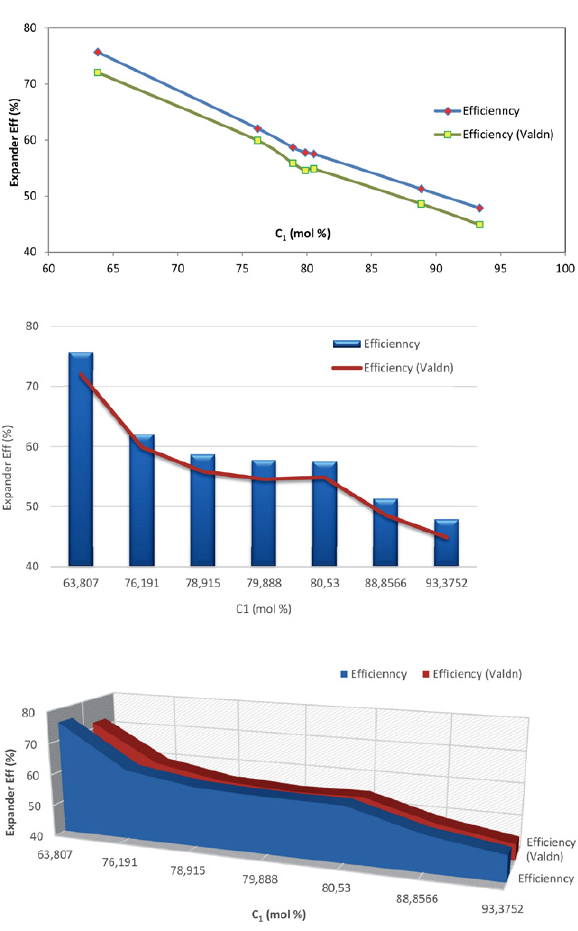
Fig. 3. Effect of methane concentration variation on expander Effi- ciency (%)